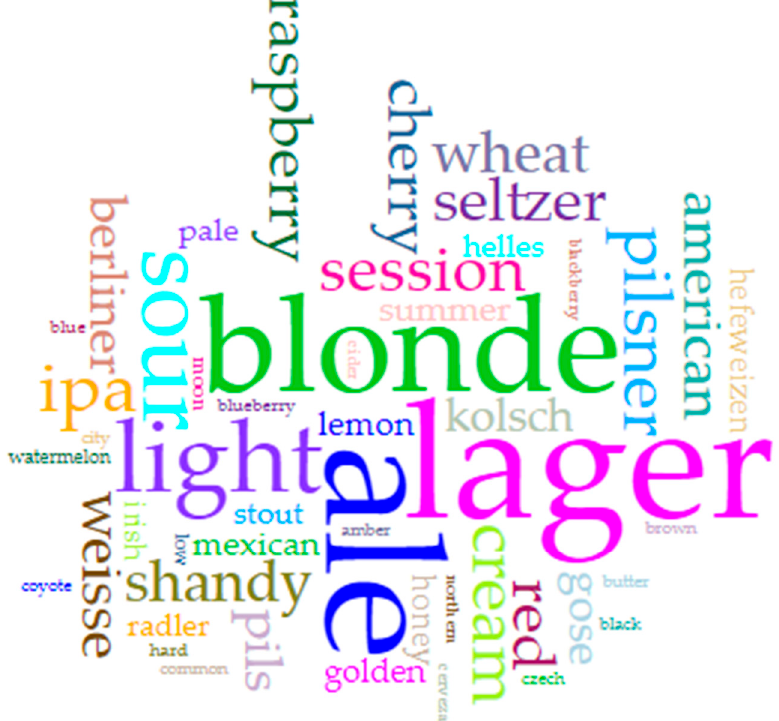
Figure 5. Word cloud (larger text indicates higher frequency of use) visualizing the frequency of word choice in the names of the lowest ABV offerings from the breweries surveyed. (Data from the authors; visualization via Voyant: https://voyant-tools.org/?corpus=51da88b672374ebe39516cd3f27ad752); accessed on 3 October 2022.